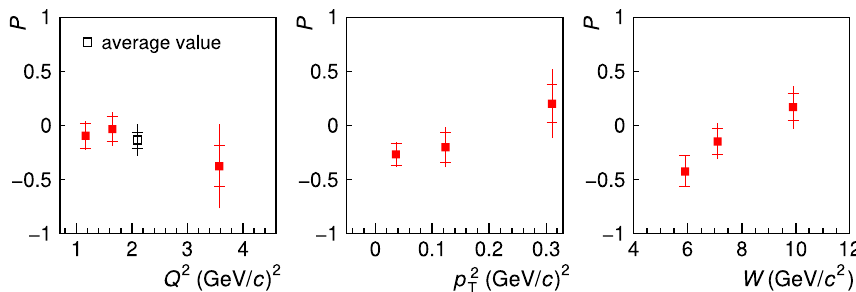
→ V T . The open symbol T